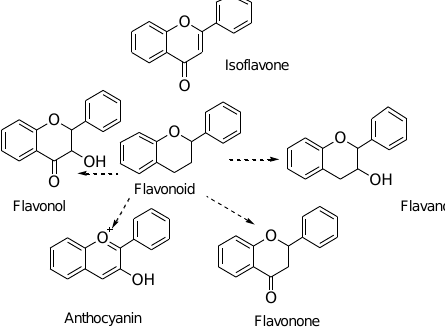
Figure 1. Chemical structure of flavonoids and its different types.